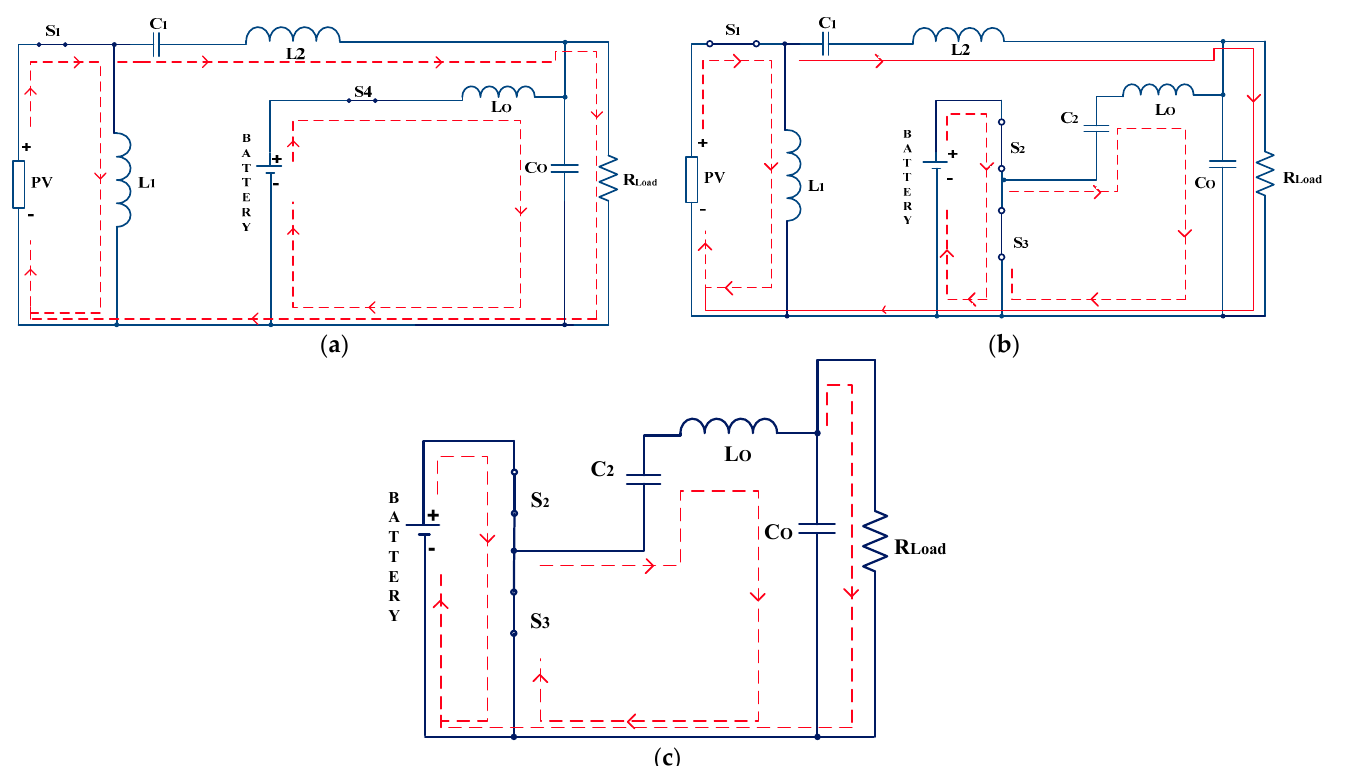
Figure 7. ( a ) Case 1: P PV > P LOAD; ( b ) Case 2: P PV < P LOAD; ( c ) Case 3: P PV = 0 (when there is no irradiation ) .